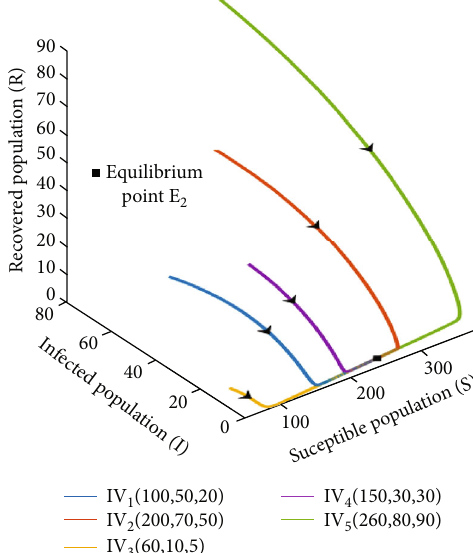
ff erent 2 for di